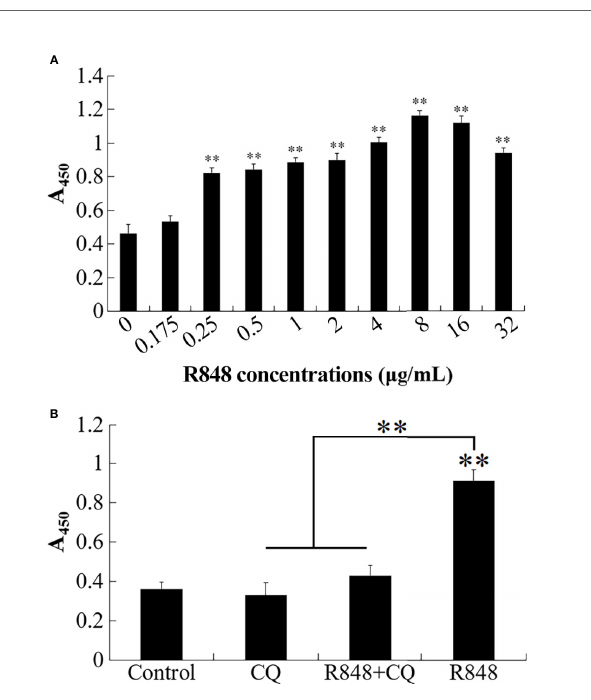
FIGURE 2 | Effect of R848 on the proliferation of HKLs. (A) Golden pompano head kidney lymphocytes (HKLs) were treated with different concentrations of R848, and then the proliferation of HKLs was examined by CCK8 assay. (B) Golden pompano HKLs were treated with or without (control) 5 µg/ml of chloroquine (CQ), 8 µg/ml R848 plus 5 µg/ml of CQ, or 8 µg/ml R848, and then examined for proliferation by CCK8 assay. Data are presented as means ± SEM (N = 3). N, the number of times the experiment was performed. **P <